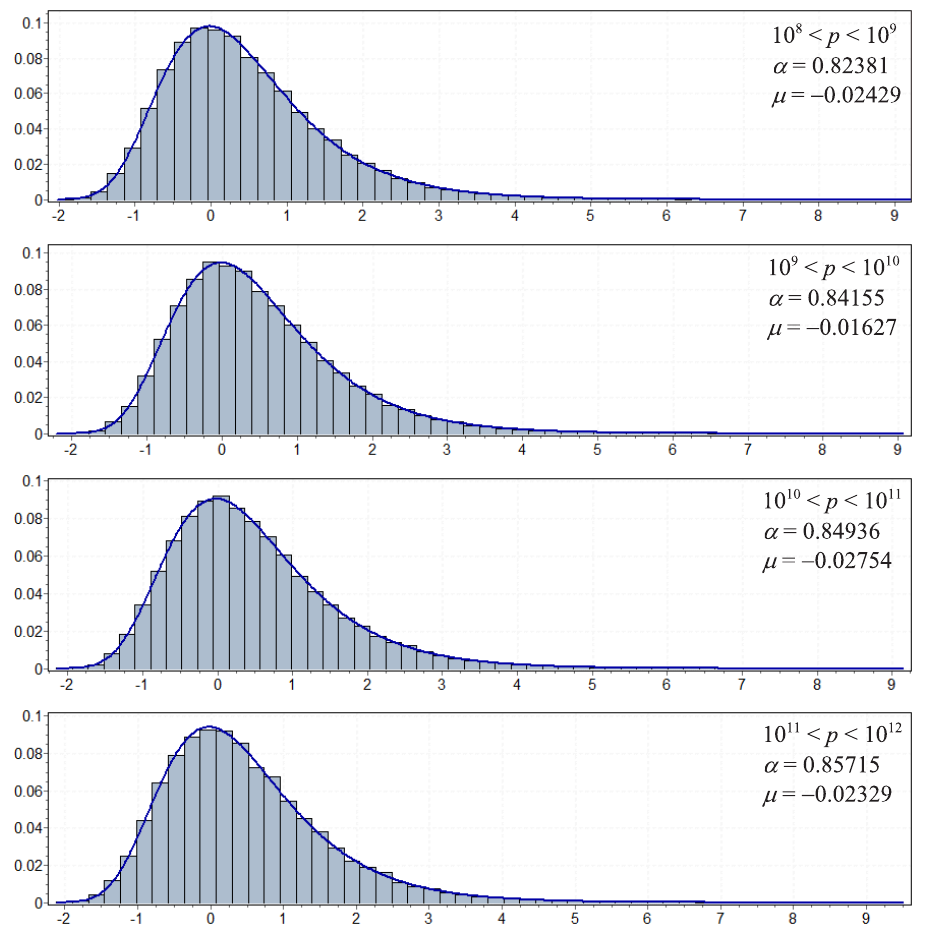
Figure 4. Histograms of w -values (47) for maximal gaps G q , r between primes p = r + nq for q = 16001, r ∈ [ 1,16000 ] . Curves are best-fit Gumbel distributions (pdfs) with scale α and mode µ